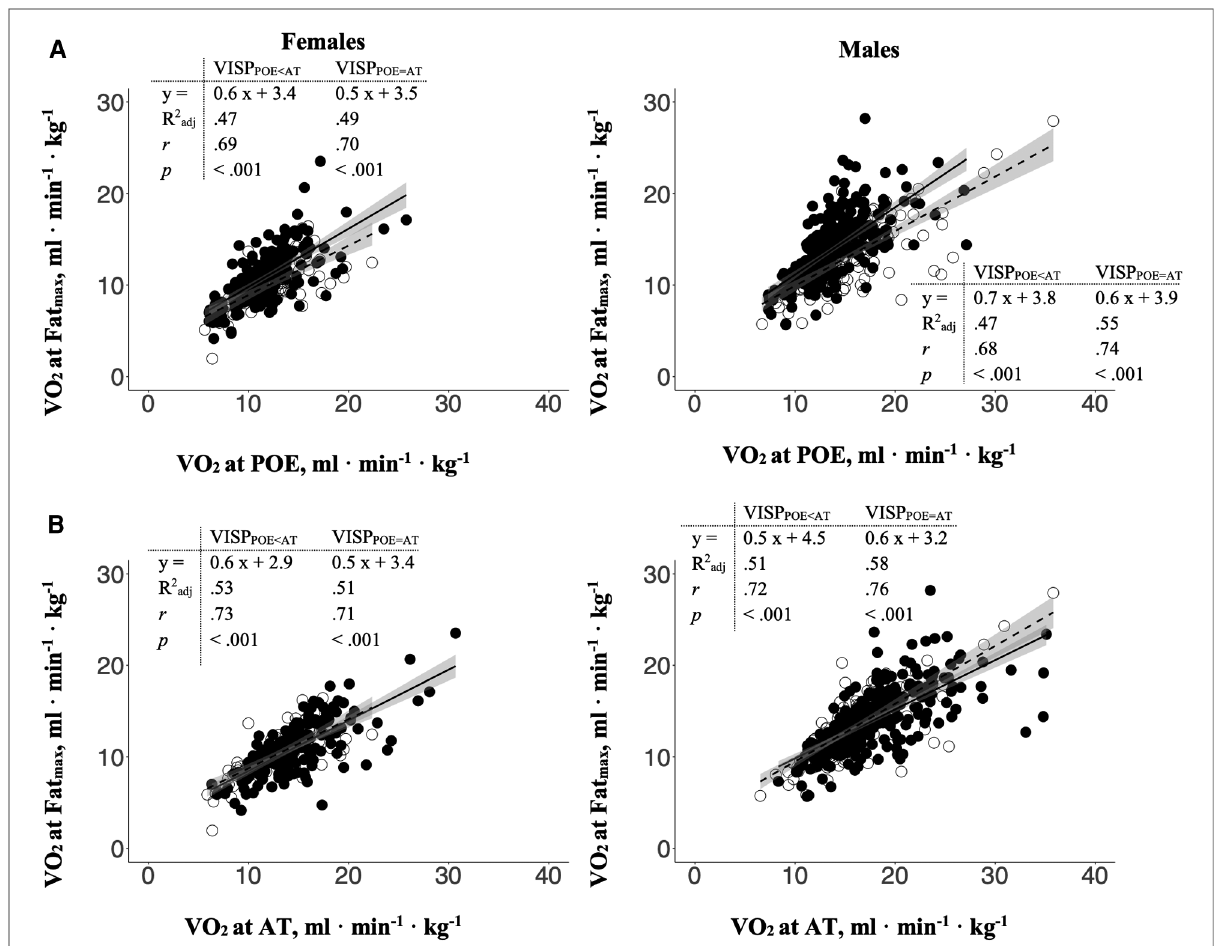
FIGURE 4 The relations between the relative oxygen uptake at Fat max with ( A ) the relative oxygen uptake at POE and ( B ) AT in VISP POE<AT (closed circles and solid line) and VISP POE=AT (open circles and dashed line), separately for females and males. Dark grey area: 95% con fi dence interval; R 2 adj : Adjusted R- square; r: Pearson ’ s product-moment correlation coef fi